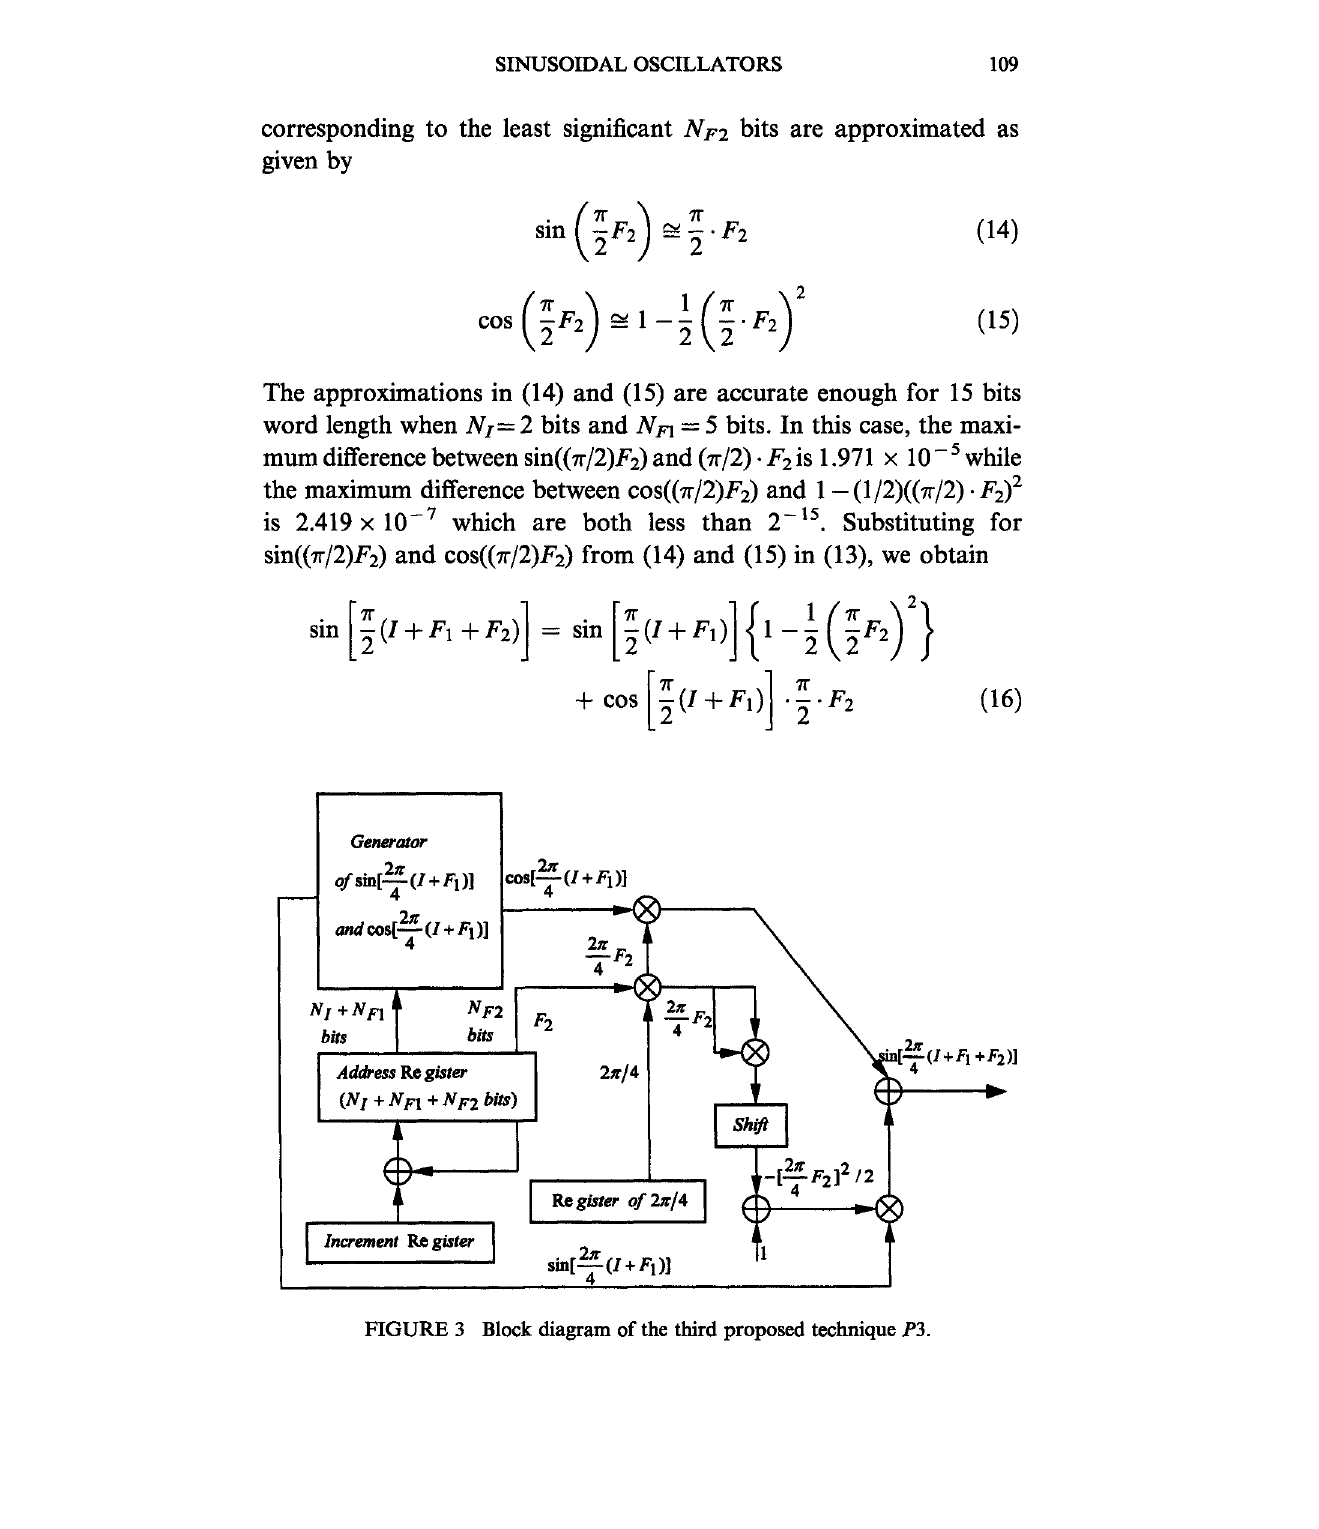
FIGURE 3 Block diagram of the third proposed technique